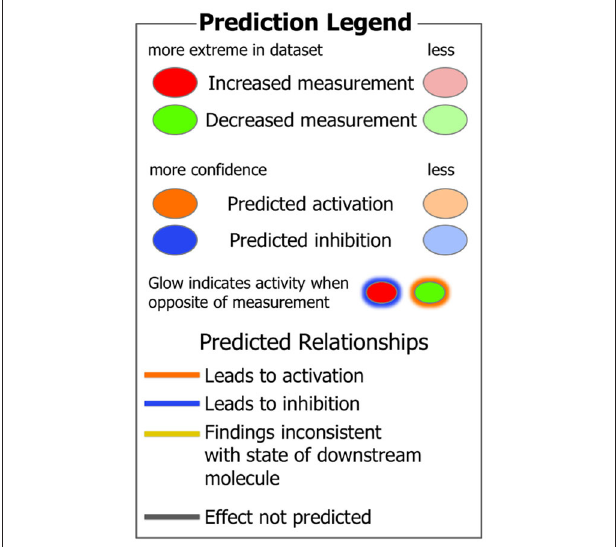
FIGURE 2 | IPA Prediction legend to help in the understanding of regulator networks.